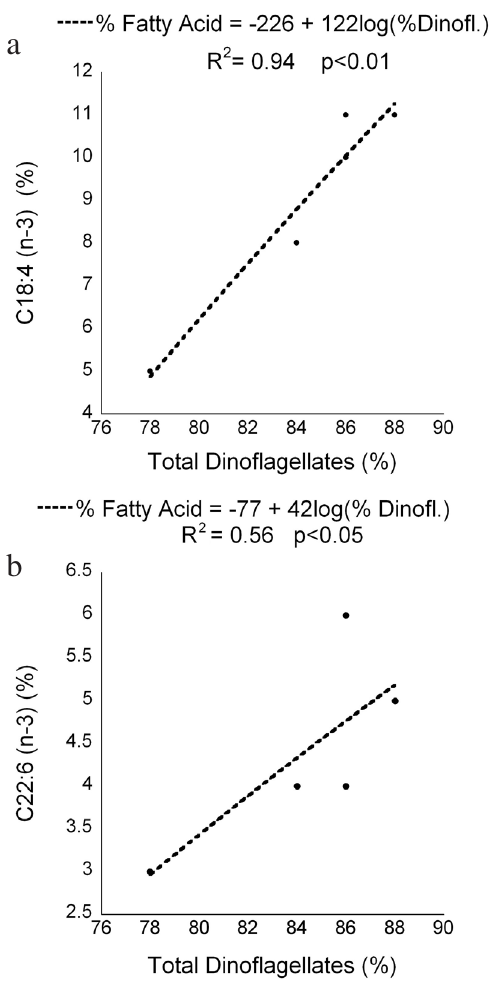
Fig . 6. – Relationship between C18:4(n-3) fatty acid (%) and to- tal dinoflagellates (%)(a), and C22:6(n-3) fatty acid (%) and total dinoflagellates (%) (b) during the 48-hour cycle at Chipana Bay. Equation and significance are shown for each curve